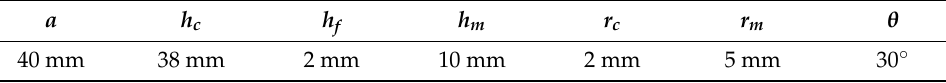
Table 1. Geometric parameters of the SPLCRR.